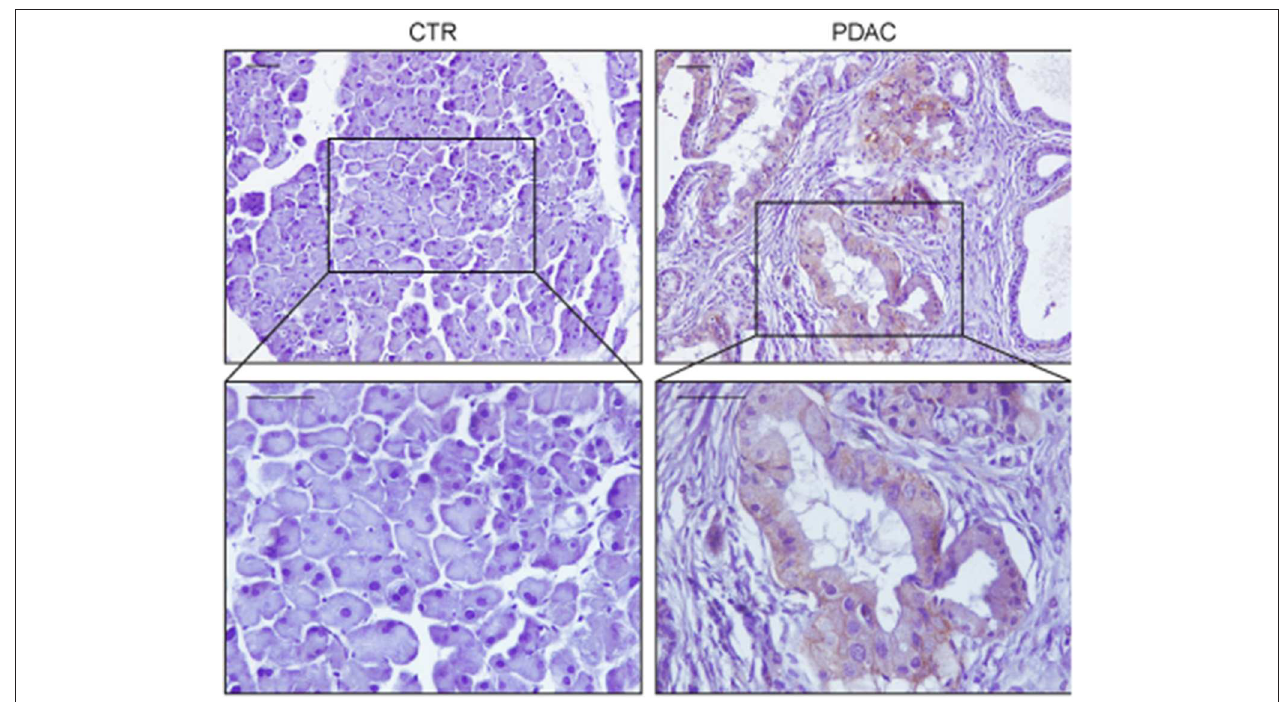
FIGURE 1 | Representative immunohistochemistry stainings of GLUT1 in sections of pancreas from a wild type mouse (CTR) or from a mouse expressing Kras G12V in the acinar/centroacinar lineages (Elas-tTA/tetOFF-Cre;K-Ras + / LSL G12V Geo ) ( 18). GLUT1 is up-regulated specifically in most tumor cells, with mixed membranous/intracellular localization. In each case pancreas was formalin fixed, paraffin embedded and slices were processed as described in Pupo et al. ( 19). Briefly, paraffin removal was performed with two 10min steps in Xylene, rehydrated in decreasing concentration of ethanol, and antigen retrieval was performed using 2100 Antigen Retriever/R-Universal buffer (Aptum Biologics). Slices were permeabilized with 0.2% TritonX, saturated in 5% goat serum/BSA and endogenous peroxidase was inhibited by H 2 O 2 incubation. Staining was performed with anti-GLUT1 antibody (AbCam, 1:200) and secondary antibody anti-Rabbit-HRP (Dako). Immunoreactivity was developed using DAB chromogen (Dako). Scale bars are 50 µ